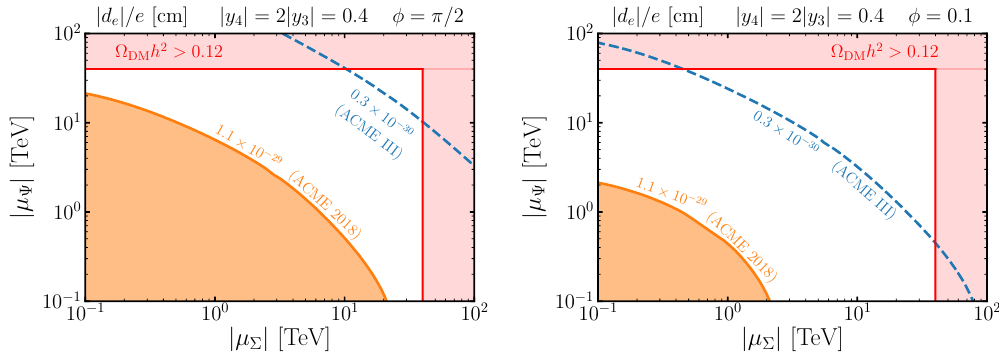
Figure 2 . Contour plots for the EDM of the electron, | d e | /e , in units of centimeters in the | µ Ψ | vs | µ Ψ | plane. The region shaded in orange is excluded by the ACME result [1] and the blue dashed line gives the projected sensitivity for ACME III [36]. The region shaded in light red corresponds to overproduction of dark matter. We have taken zero scalar mixing angle. The left (right) panel corresponds to a CP-violating phase φ = arg( y ∗ y ∗ µ Σ µ Ψ ) = π/ 2 ( φ = 0 . 1 3 4